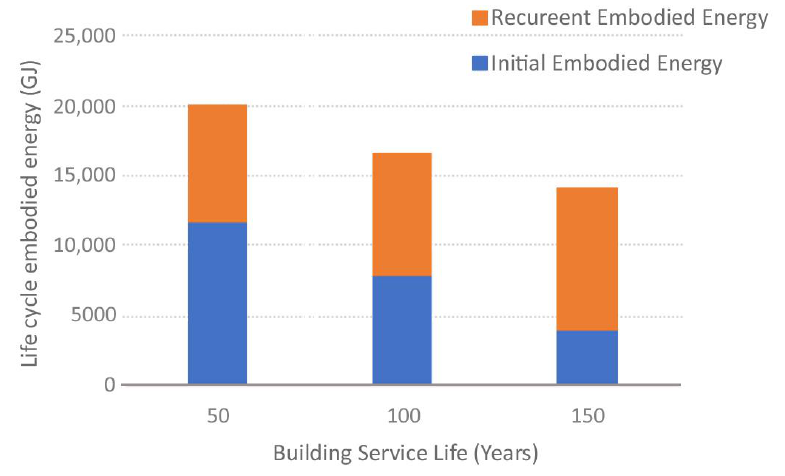
Figure 7. Life cycle embodied energy of the case study house with the average material service life for building service lives of 50, 100 and 150 years over an assessment period of 150 years.